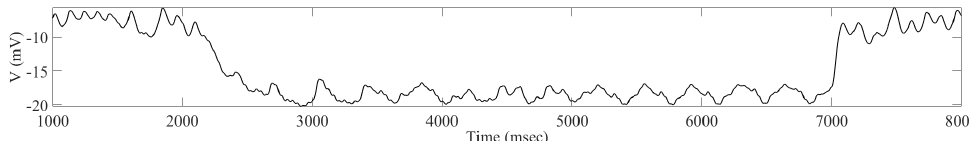
Figure 10. The total filtered local field potential of the 16 STN neurons from 1000 to 8000 ms with aLFPDBS parameters a 0 = 10 and intt =